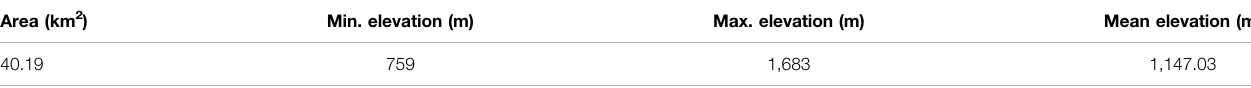
TABLE 6 | Topographic report for Š tavska River basin (elevation above sea level).